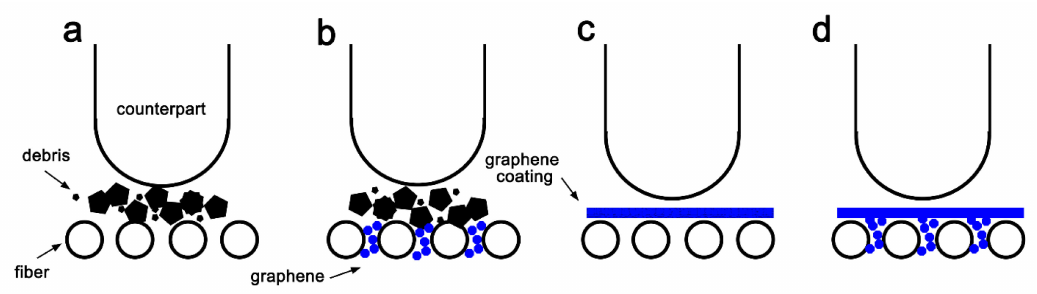
Figure 13. Variation of COF of prepared composites: ( a ) Raw GFRP, ( b ) I-0.4 g, ( c ) B-0.4 g, ( d ) C-0.4 g.